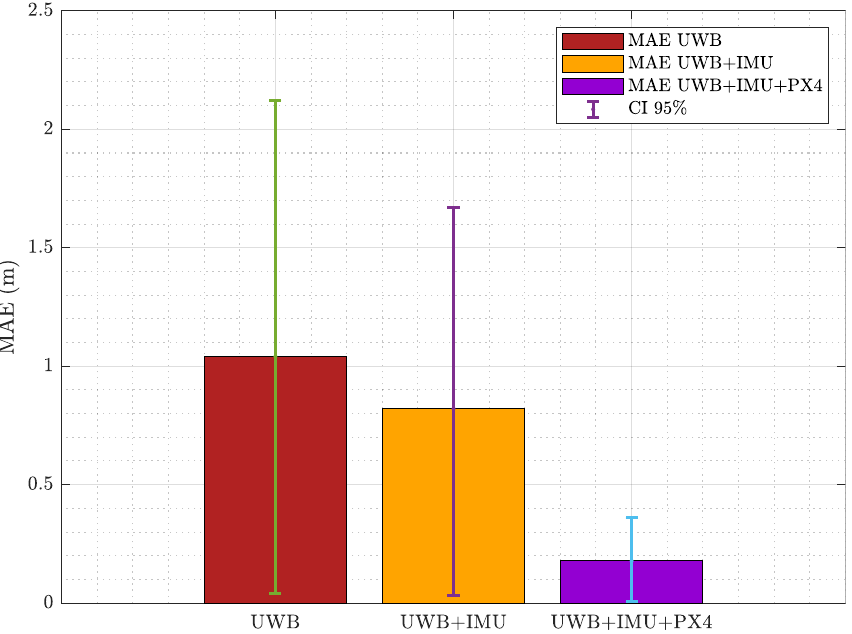
Figure 10. MAE of position estimation in scenario A.